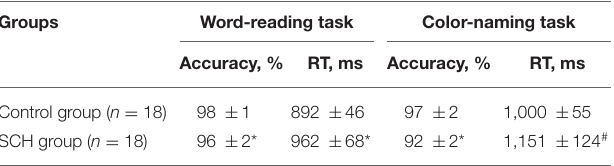
TABLE 2 | Performance accuracy and reaction time of the Stroop task (mean ±